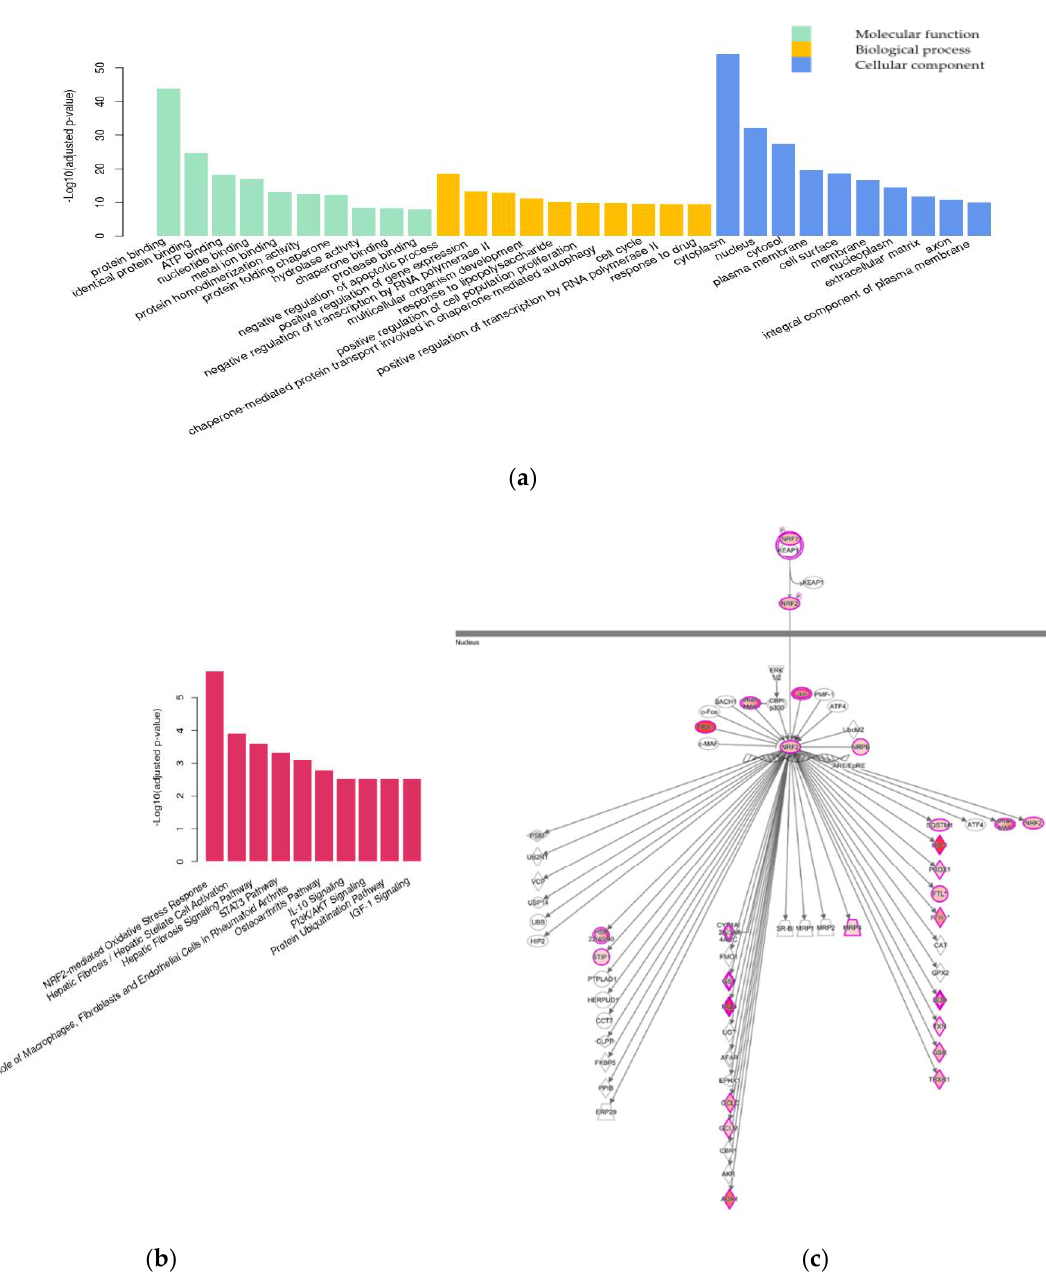
Figure 4. Gene Ontology (GO) enrichment analysis and pathway analysis of differentially expressed genes (DEGs) among differentiated neuronal cells affected by neurotoxicity induced by TDP-43 and ethacrynic acid. ( a ) The top 10 significantly enriched GO terms according to a hypergeometric test p -value adjusted with the Benjamini–Hochberg (BH) procedure. Green bars: GO terms in molecular function category; orange bars: GO terms in biological process category; blue bars: GO terms in cellular component category. ( b ) The top 10 significant pathways according to p -value adjusted with the BH procedure. ( c ) The illustration of the nuclear erythroid 2-related-factor (Nrf2)-mediated oxidative stress response pathway is generated using the Ingenuity Pathway Analysis software. Red objects represent genes that were upregulated in the neurotoxic condition induced by TDP-43 and ethacrynic acid.